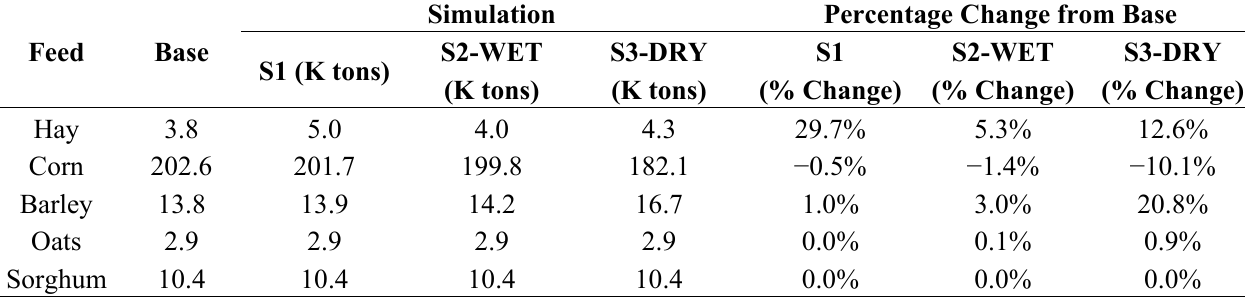
Table 5. Feed consumed in Base and Climate Change Simulations. Source: Model Runs from Colorado